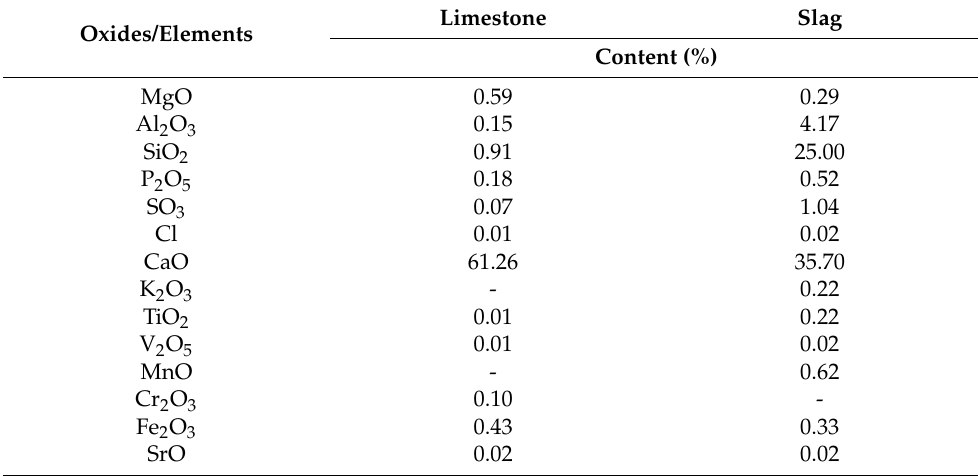
Table 5. Chemical composition of the ground limestone and granulated